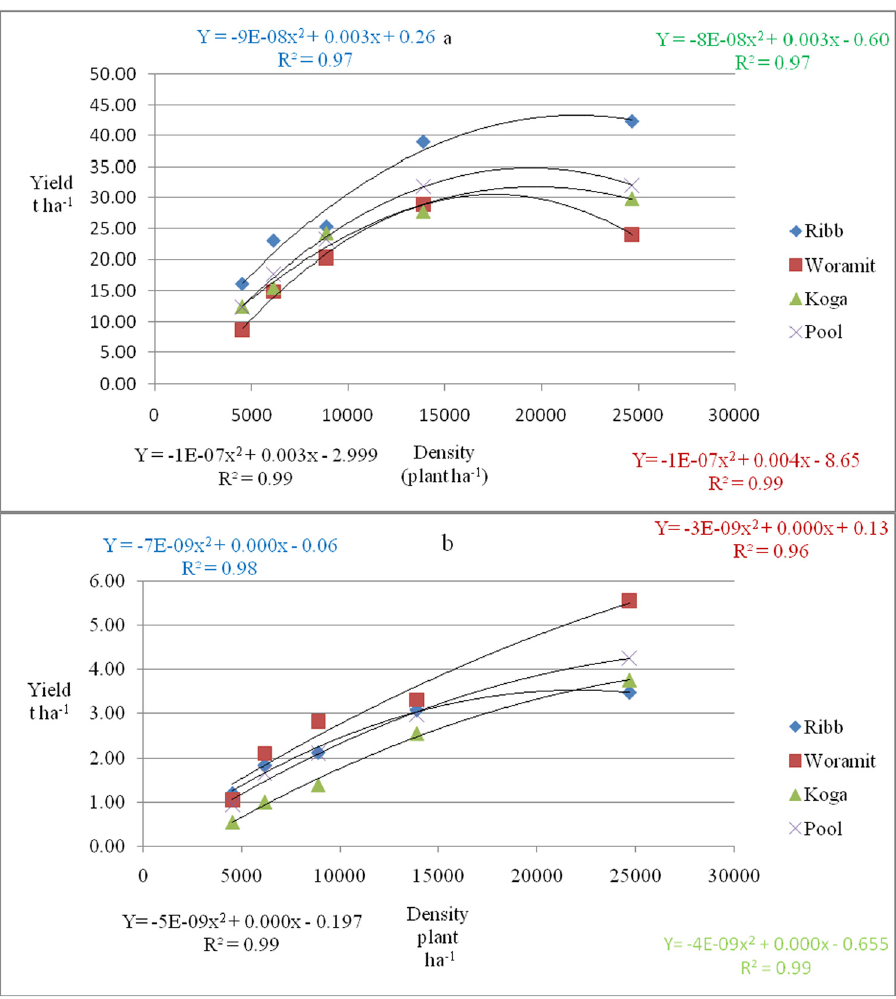
Figure 4: Trends of watermelon fruit yield ( a ) marketable and ( b ) unmarketable ( t ha − 1 ) as in fl uenced by plant density in each